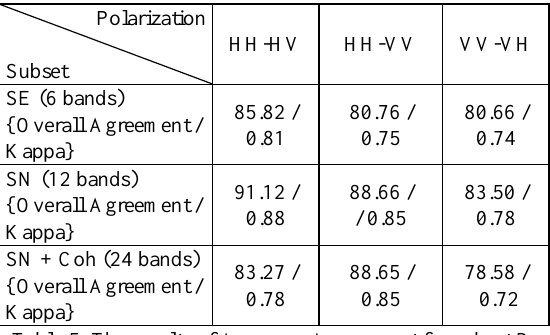
Table 5. The results of Accuracy Assessment for subset D extracted from Standard Dual-Pol data for 5 thematic